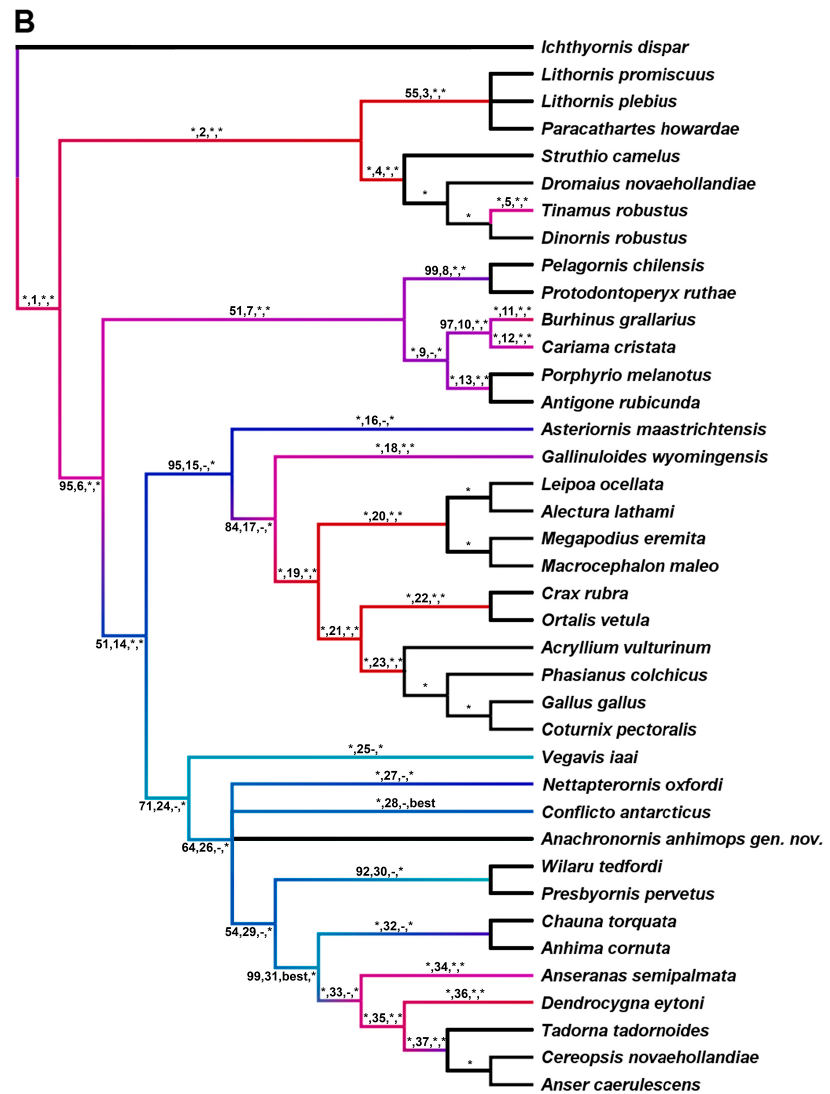
Figure 9. Phylogeny reconstructions of dataset 7. Phylogenetically constrained maximum parsimony tree ( A ), and the phylogenetically constrained total-evidence (tip-dated) Bayesian tree ( B ). Graduated branch colors are proportional to p values determined by parsimony Kishino–Hasegawa (KH) test (blue, high p , i.e., not significantly different than “best”; red, low p , i.e., significantly different than “best”; black, not tested) wherein Anachronornis nov. gen. is moved from the position shown to each of the colored branches defined by constraint trees. Branch color in B is relative to the position of Anachronornis nov. gen. on tree 53, which was ranked “best” when 15 alternative backbone trees were included (tree 53: Vegavis sister to Neornithes, Anachronornis nov. gen. sister to Anhimidae plus Pan-Anseres; see Table S6, Supplementary Appendix G9 for details). Branch annotations separated by commas are as follows: (1) support value (( A ) bootstrap; ( B ) posterior probability; “*” indicates support of 100%; “-“ indicates support below 50%), (2) constraint tree number (note: ( A ) and ( B ) differ), (3) result of parsimony KH (“-” indicates no significant difference from “best” ( p > 0.05), “*” indicates a significant difference from “best” ( p < 0.05)), and (4) result of likelihood KH test, normal approximation, equal rates (“-” indicates no significant difference from “best” ( p > 0.05), “*” indicates a significant difference from “best” ( p < 0.05)). See Supplemental Material, Table S6 ( A ) and Table S7 ( B ) and Appendices G9, G11, and G13–G15 for these and additional KH constraint trees and KH scores. Single labels on black branches represent bootstrap ( A ) or posterior probability ( B